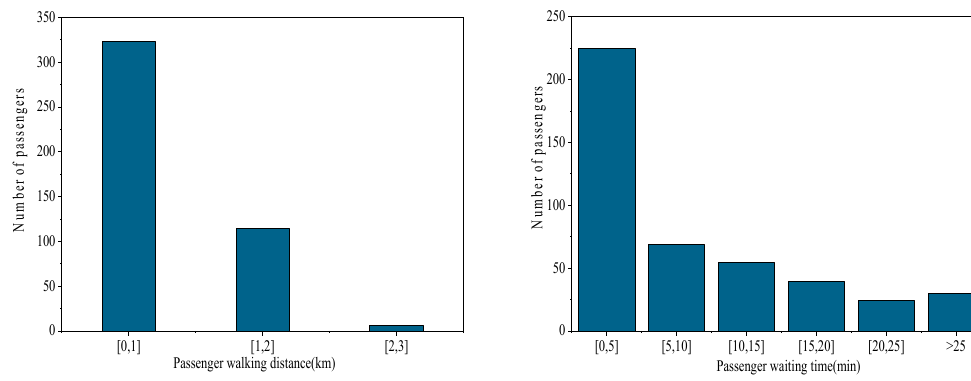
Figure 12. Passenger walking distance and waiting time.